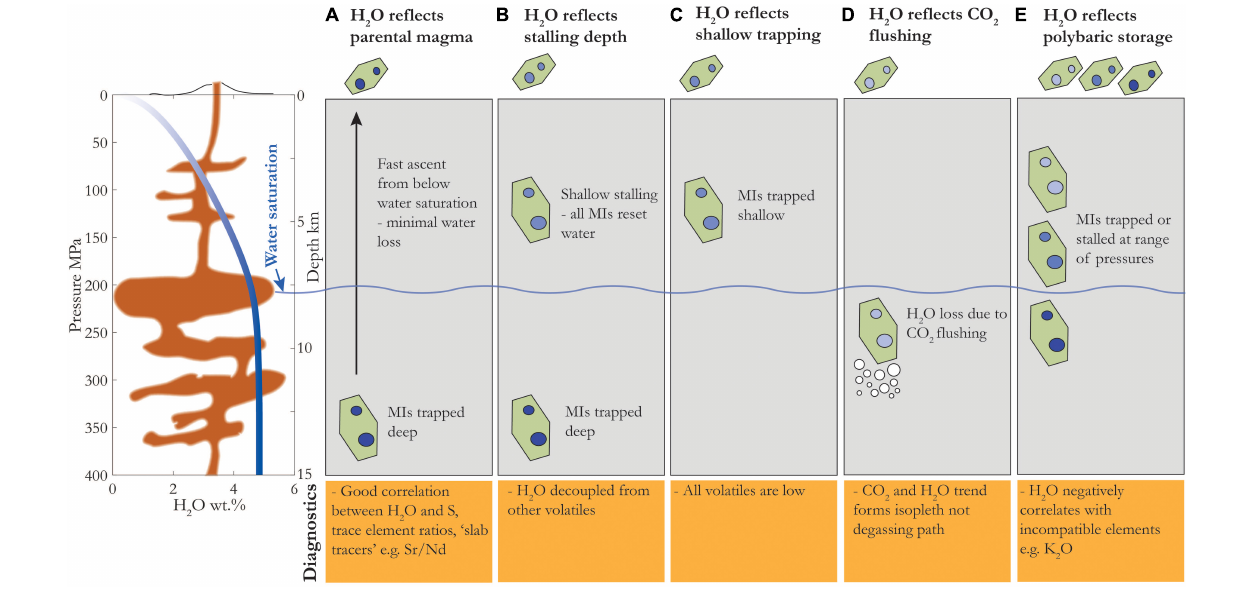
FIGURE 7 | Schematic showing different processes affecting MI H 2 O concentrations – labels correspond to text headings above. Left: Water solubility as a function of pressure from SolEx for Cerro Negro basaltic composition with 4.75 wt% initial H 2 O. Depth shown for illustrative purposes, assuming density of 2.7 g/cm 3 . Water saturation depth shown as wavy blue line ( ∼ 200 MPa for 4.75 wt% H 2 O). Note that for simplicity, we have used the water saturation pressure as the critical pressure below which water loss becomes significant but some water loss will occur deeper than this if the magma is saturated in a vapor phase, particularly for CO 2 -rich magmas. Below in orange: key diagnostics to infer different magmatic processes. Crystals above gray boxes indicate erupted product. MI color tint reflects H 2 O concentrations, with lighter tints having lower